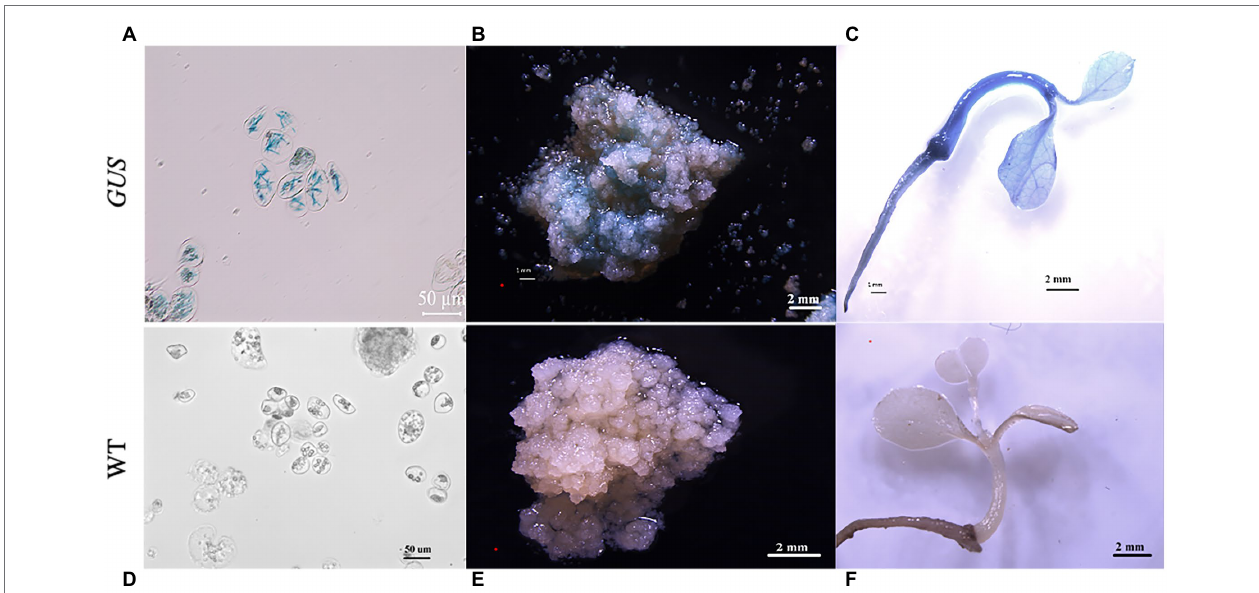
FIGURE 6 | Histochemical staining for ß -glucuronidase ( GUS ) activity in the transgenic plants. Histochemical staining for GUS activity in transformed single cells (A) , callus clumps (B) , and plants (C) . (D) Histochemical staining for GUS activity in the non-transformed single cells (control). (E) Non-transformed callus clumps (control) and (F) plants. (A,D) : scale bar = 50 μ m; (B,C,E,F) scale bar = 2 mm.